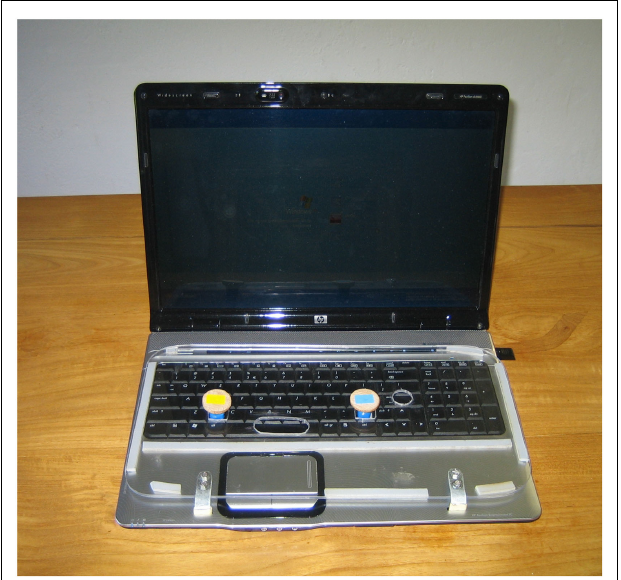
FIGURE 1 | Laptop computer with adjusted response buttons. The computer keyboard was shielded with a perspex plate such that hands and wrists could rest comfortably on the plate, which minimized tremor and prevented unintentional depressing of other